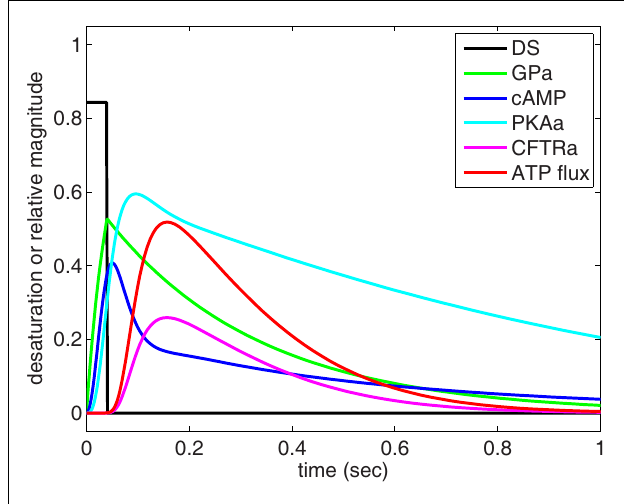
FIGURE 3 | Dynamic behavior of our model of oxygen-dependent erythrocyteATP release. Hemoglobin oxygen saturation is decreased from 100 to 15.7% for 40ms, resulting in activation of the ATP release pathway with an initial delay in ATP release followed by a peak in ATP flux at approximately 150ms.The pulse of hemoglobin desaturation results in a total release of ATP (area under ATP flux curve) that can be compared to experimental measurements.The ATP release delay and peak times are consistent with shear-dependent release dynamics measured byWan et al. (2008), and the GP activation time-scale is consistent with the measurements of Hein et al. (2005).